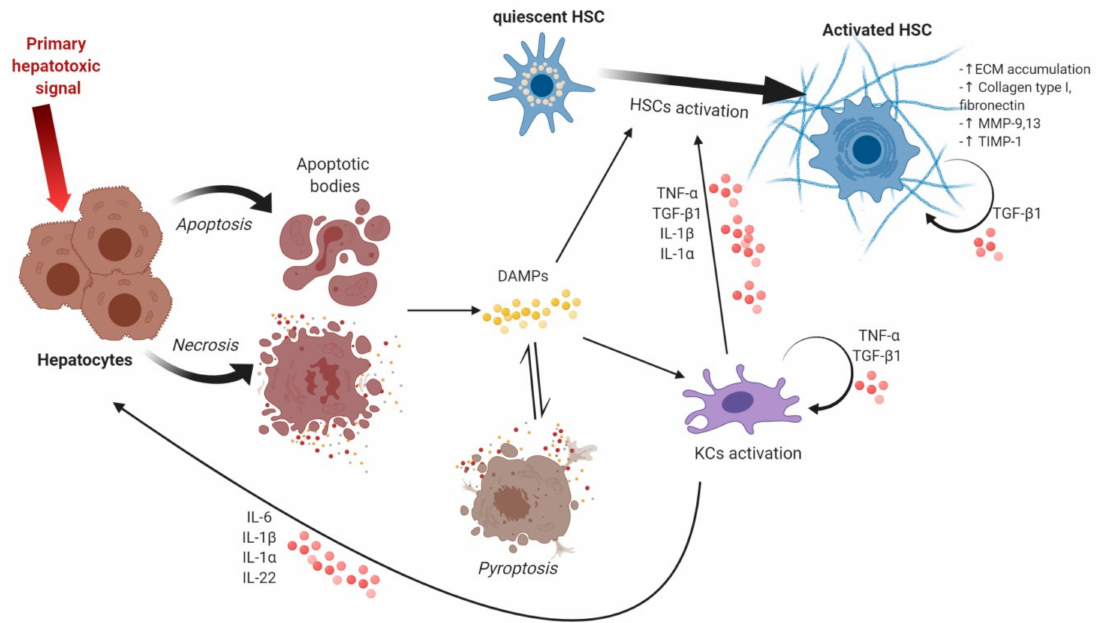
Figure 1. Events leading to hepatic stellate cells (HSCs) activation and accumulation of extracellular matrix. The hepatotoxic signal is the first to induce cellular death in hepatocytes by either apoptosis or necrosis, both types of death being followed by danger-associated molecular patterns (DAMPs) release. DAMPs can act on Kup ff er cells (KCs) by activating them and trigger inflammatory cytokines and chemokines release that can act on hepatocytes, HSCs and on themselves. DAMPs can also be involved in promoting HSCs activation characterized by an increase in extracellular matrix (ECM) accumulation, collagen type I, fibronectin, metalloproteinase (MMP-9, 13), tissue inhibitor of metalloproteinases (TIMP-1), all fibrogenic markers. Pyroptosis is induced by DAMPs and triggers a self-perpetuating loop as more DAMPs are released following pyroptotic death. Figure created with